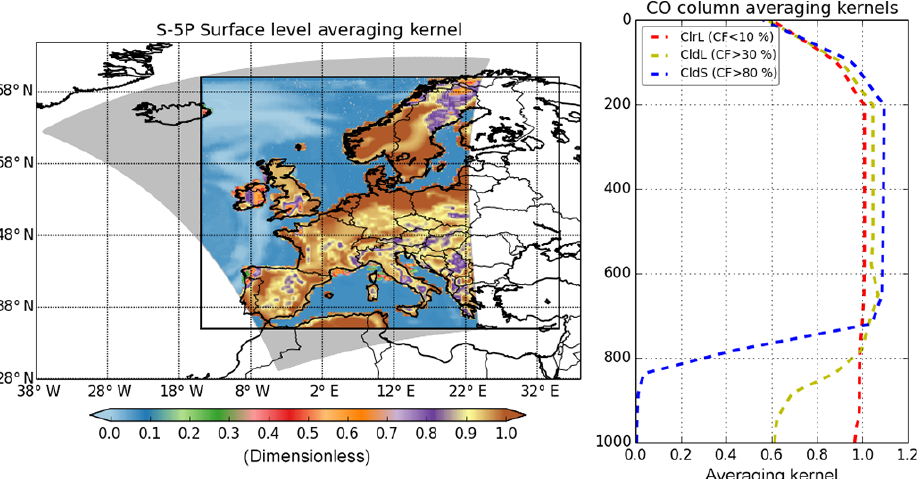
Figure 4. Left panel: S-5P CO averaging kernel values at the surface. Labels are longitude in degrees ( x axis) by latitude in degrees ( y axis). Right panel: averaging kernels for land pixels with cloud fraction less than 10% (dashed red lines), for land pixels with cloud fraction greater than 30% (dashed yellow lines), and for sea pixels with cloud fraction greater than 80% (dashed blue lines). The averaging kernels are for an average of the data shown on the swath for 1 June 2003 at 12:34UTC. Labels are averaging kernel, normalized ( x axis) by pressure level in hPa ( y